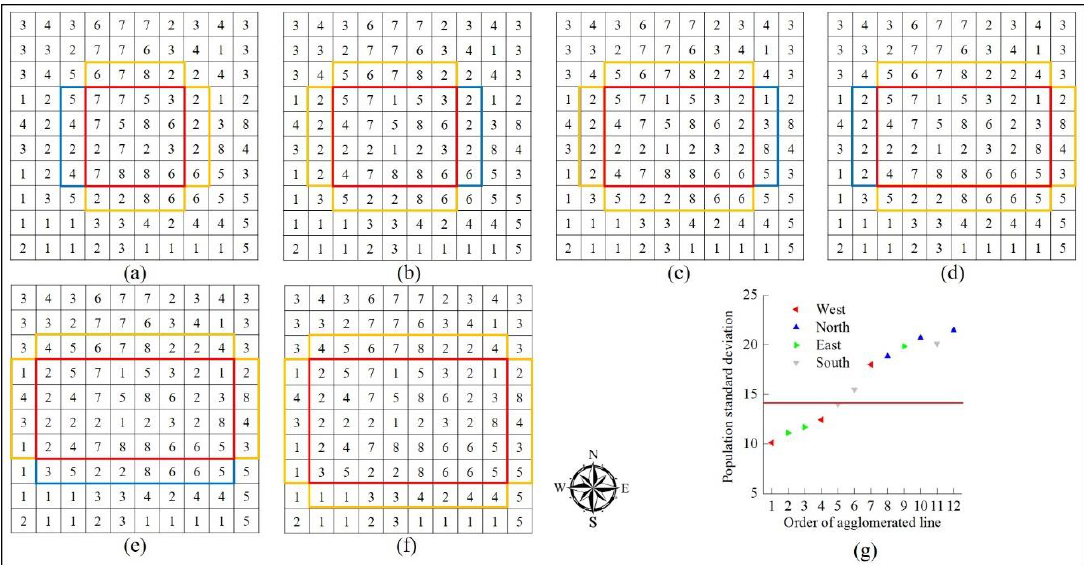
Figure 3. The Agglomeration of Inner Lines (AIL) method of detecting edge effected regions (EER) with reduced fire frequency (FF), using the same hypothetical landscape as in Figure 2. ( a ) An initial interior of 4 × 4 grids located in the center of the landscape (outlined in red) has four lines of grids outlined along its edges. The line whose addition to the initial window resulted in the smallest increase in the population standard deviation in FF, and that was below the threshold value, is outlined in blue and the other three lines are outlined in yellow. ( b – e ) The initial window that is enlarged by the AIL has four lines of grids outlined along its edges, and the line that met the criteria described in ( a ) is outlined in blue. ( f ) The AIL process was stopped as the agglomeration of any of the four lines exceeded the EER AIL threshold. ( g ) Relations between the order of the agglomerated line and the population standard deviation in FF of the agglomerated line; the five lines agglomerated in steps ( a ) to ( e ) were below the EER AIL threshold (red line), but subsequent lines were above it. The symbol color indicates the compass direction of the AIL relative to the initial interior.